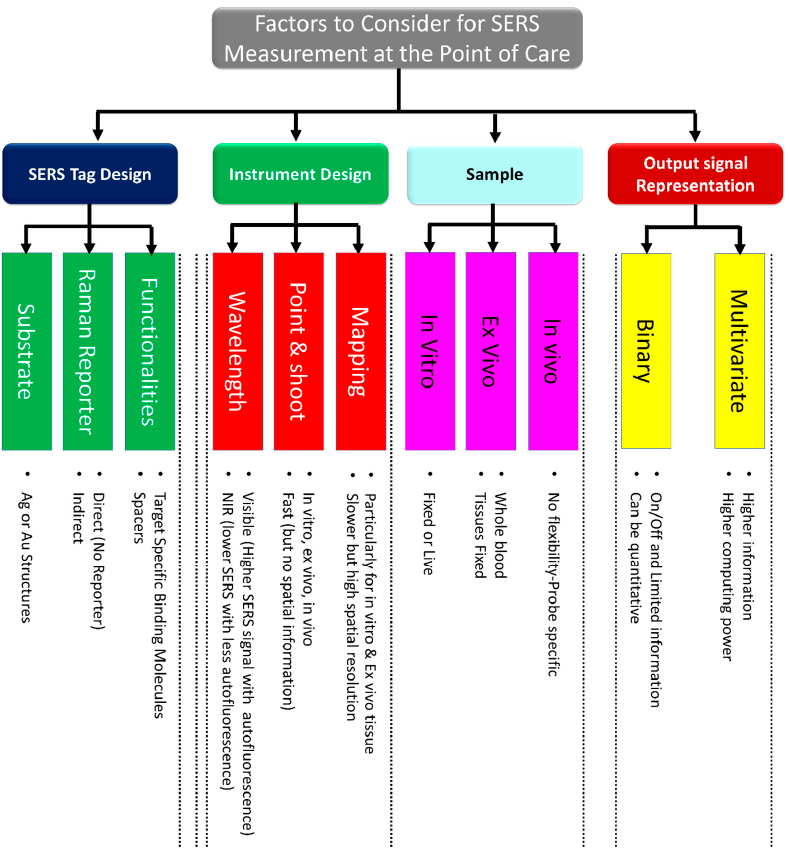
Figure 4. List of the most important factors to consider when performing SERS measurements at the point of care.